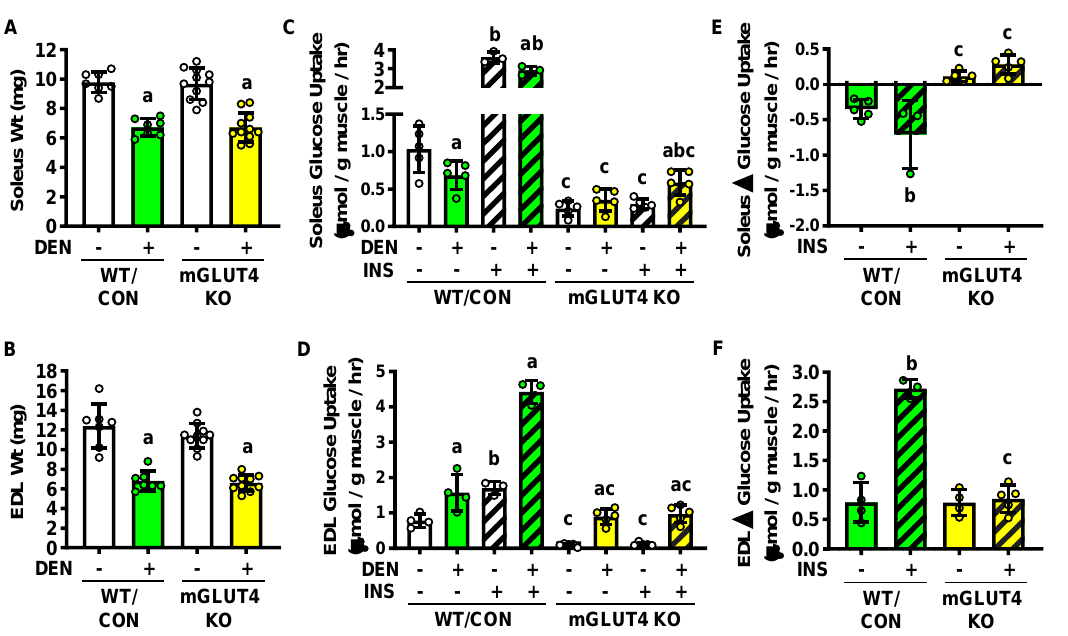
Figure 5. Loss of GLUT4 alters the effects of long-term denervation (DEN) on muscle glucose uptake. In male wild- type/control (WT/CON) and muscle-specific GLUT4 knockout (mGLUT4 KO) mice, hindlimb muscle DEN was induced in one leg for 28 days while the contralateral leg was sham-operated (-). ( A ) Soleus and ( B ) EDL muscle weights. ( C , D ) Ex vivo muscle [ 3 H]-2-deoxy-D-glucose uptake was assessed in the presence of 0 or 50 mU/ml insulin (INS). ( E , F ) DEN-induced change in muscle glucose uptake relative to the contralateral control muscle. Statistical significance was defined as p < 0.05 and determined using two-way ANOVAs and Tukey’s post-hoc analysis (Panels A and B : n = 7–11 muscles/group; Panels E and F : n = 3–5 muscles/group), three-way ANOVAs, Two-Way ANOVAs and Tukey’s post-hoc analysis ( C and D : n = 3–5 muscles/group). Significance is denoted by ‘a’ vs. -, ‘b’ vs. 0 mU/ml INS, and ‘c’ vs. WT/CON.